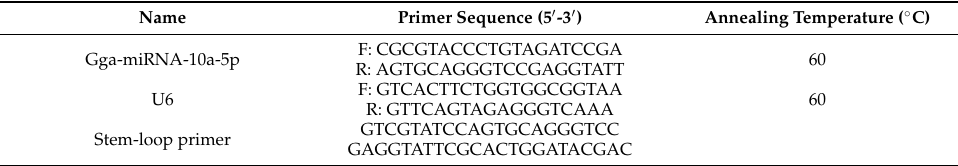
Table 1. miRNA primers used for qRT-PCR.